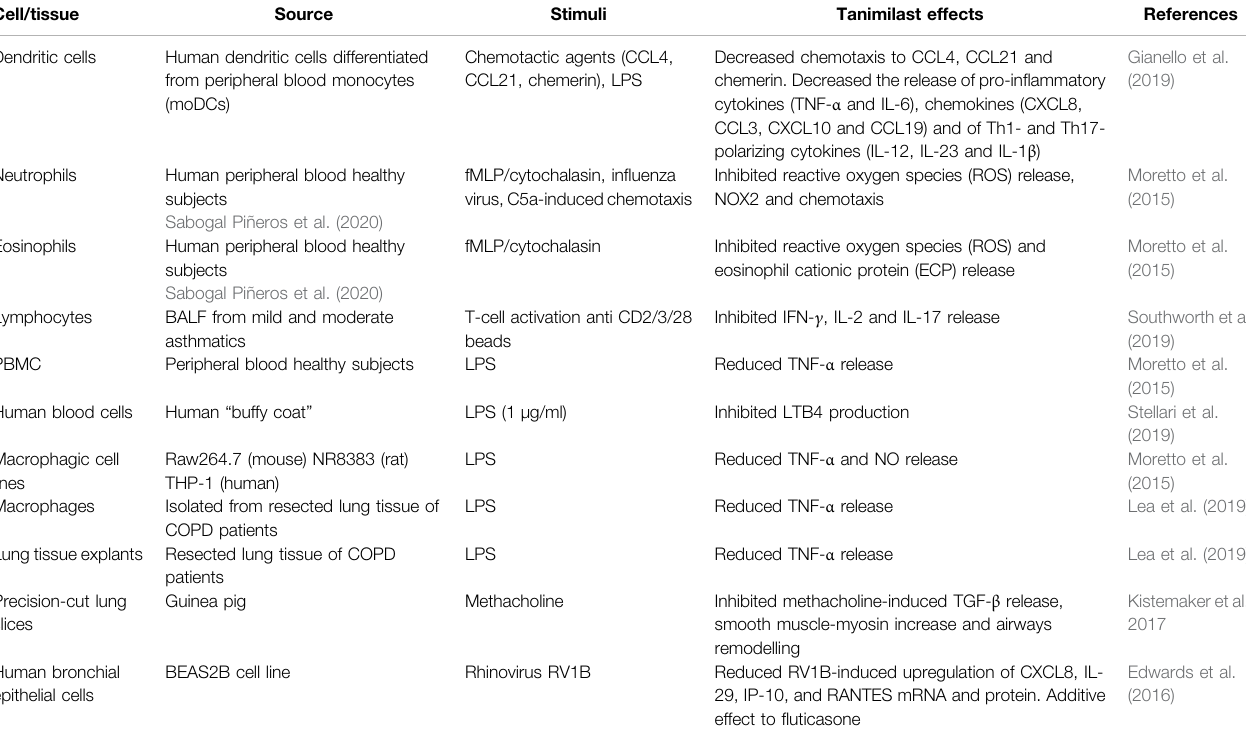
TABLE 1 | Tanimilast anti-in fl ammatory effects in vitro in various cell-based assays encompassing human and rodents ’ cellular preparations.